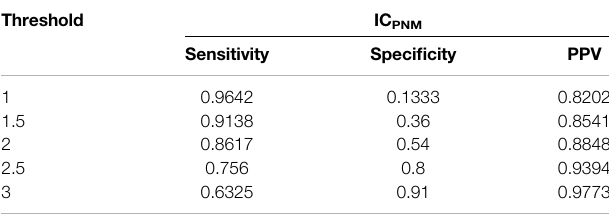
TABLE 5 | Performance metrics of IC PNM based on the different threshold values, sensitivity, speci fi city and PPV using FAERS 2014 – 2019Q2 data. Threshold IC